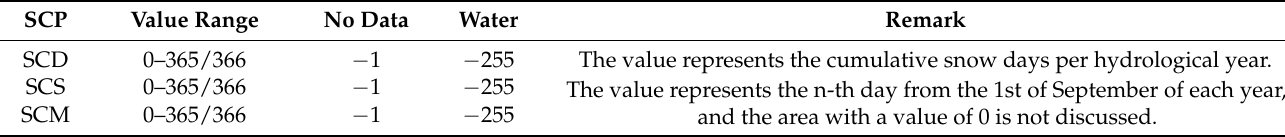
Table 2. NIEER MODIS SCP product